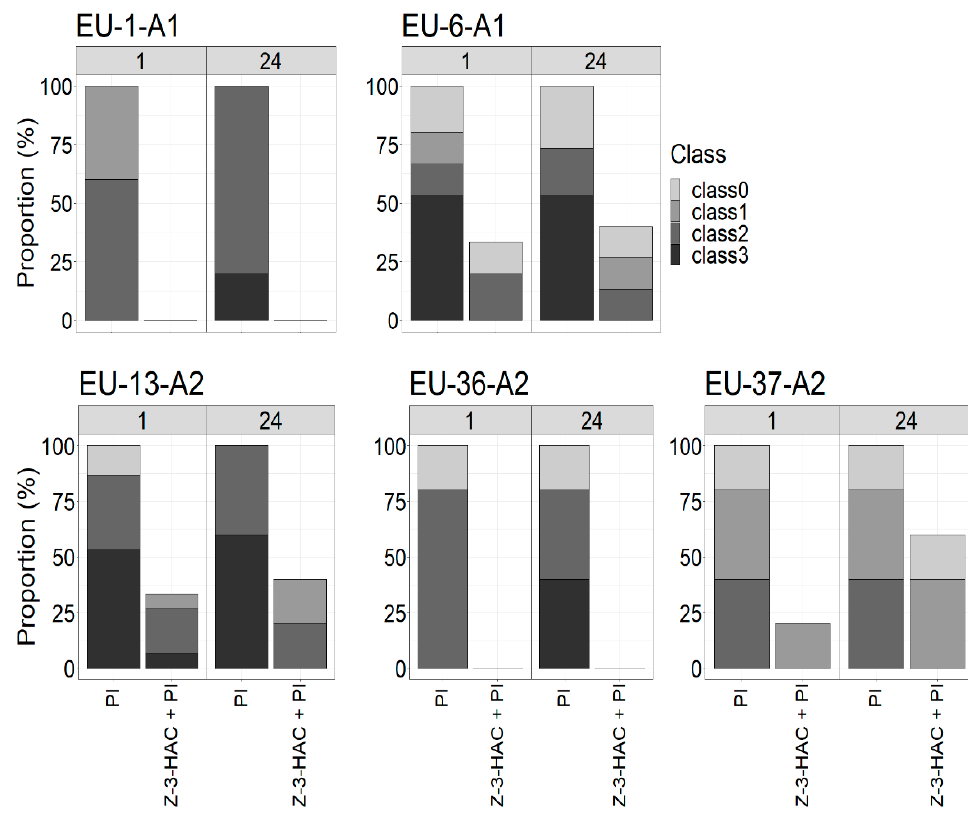
Figure 4. Sporulation intensity proportion of potato leaves belonging to the four sporulation levels (0 = no sporulation, 1 = weak sporulation, 2 = medium sporulation, 3 = high sporulation) on unexposed leaves inoculated with various P. infestans genotypes (EU-1-A1, EU-6-A1, EU-13-A2, EU-36-A2, EU-37-A2) (PI) and on leaves pre-exposed to the Z-3-HAC and subsequent infection with P. infestans genotypes (Z-3-HAC + PI) at 1 and 24 h postexposure. The class distribution between treated and untreated leaves was significantly different according to chi-square test ( p -value < 0.01). All measurements were assessed seven days after infection.